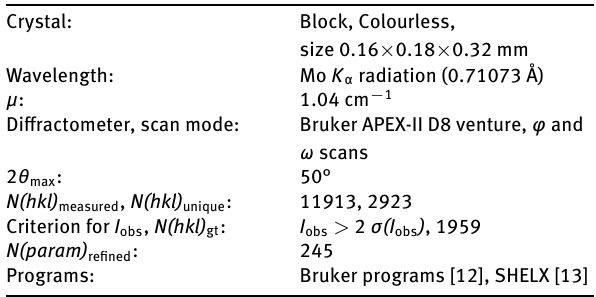
Table 2: Fractional atomic coordinates and isotropic or equivalent isotropic displacement parameters (Å 2